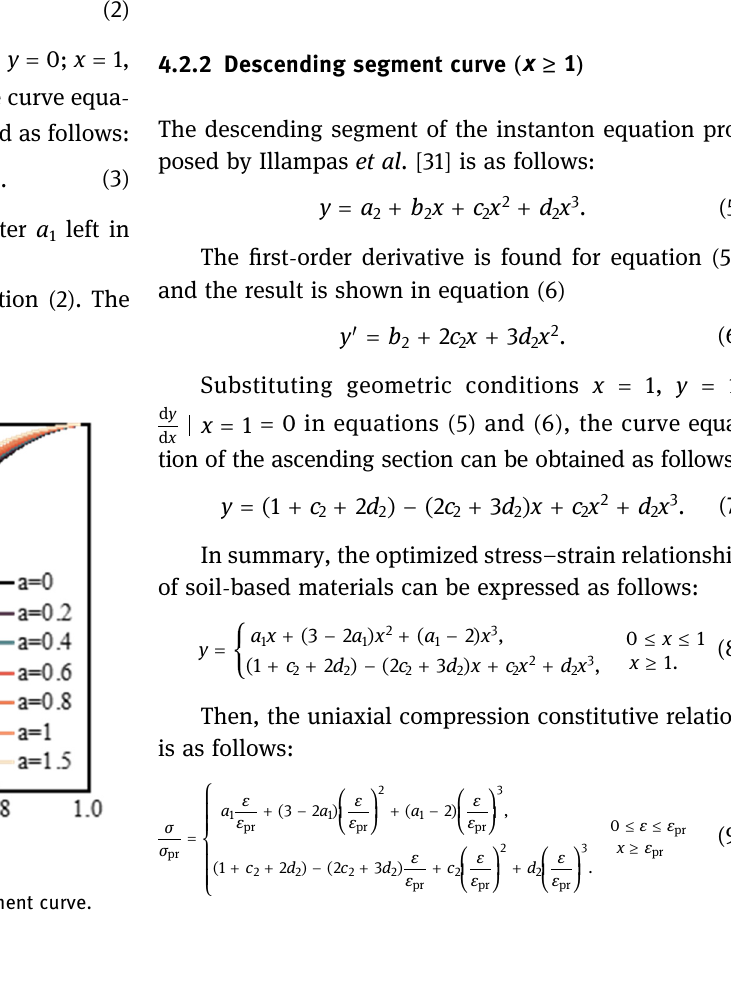
Table 6: Rising segment parameter values